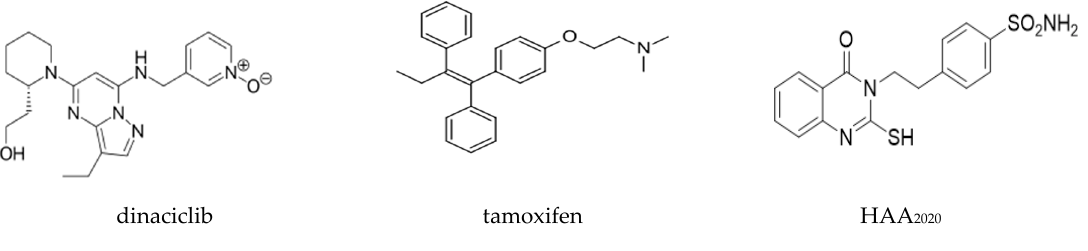
Figure 10. Molecular structures of dinaciclib, tamoxifen, and HAA 2020.